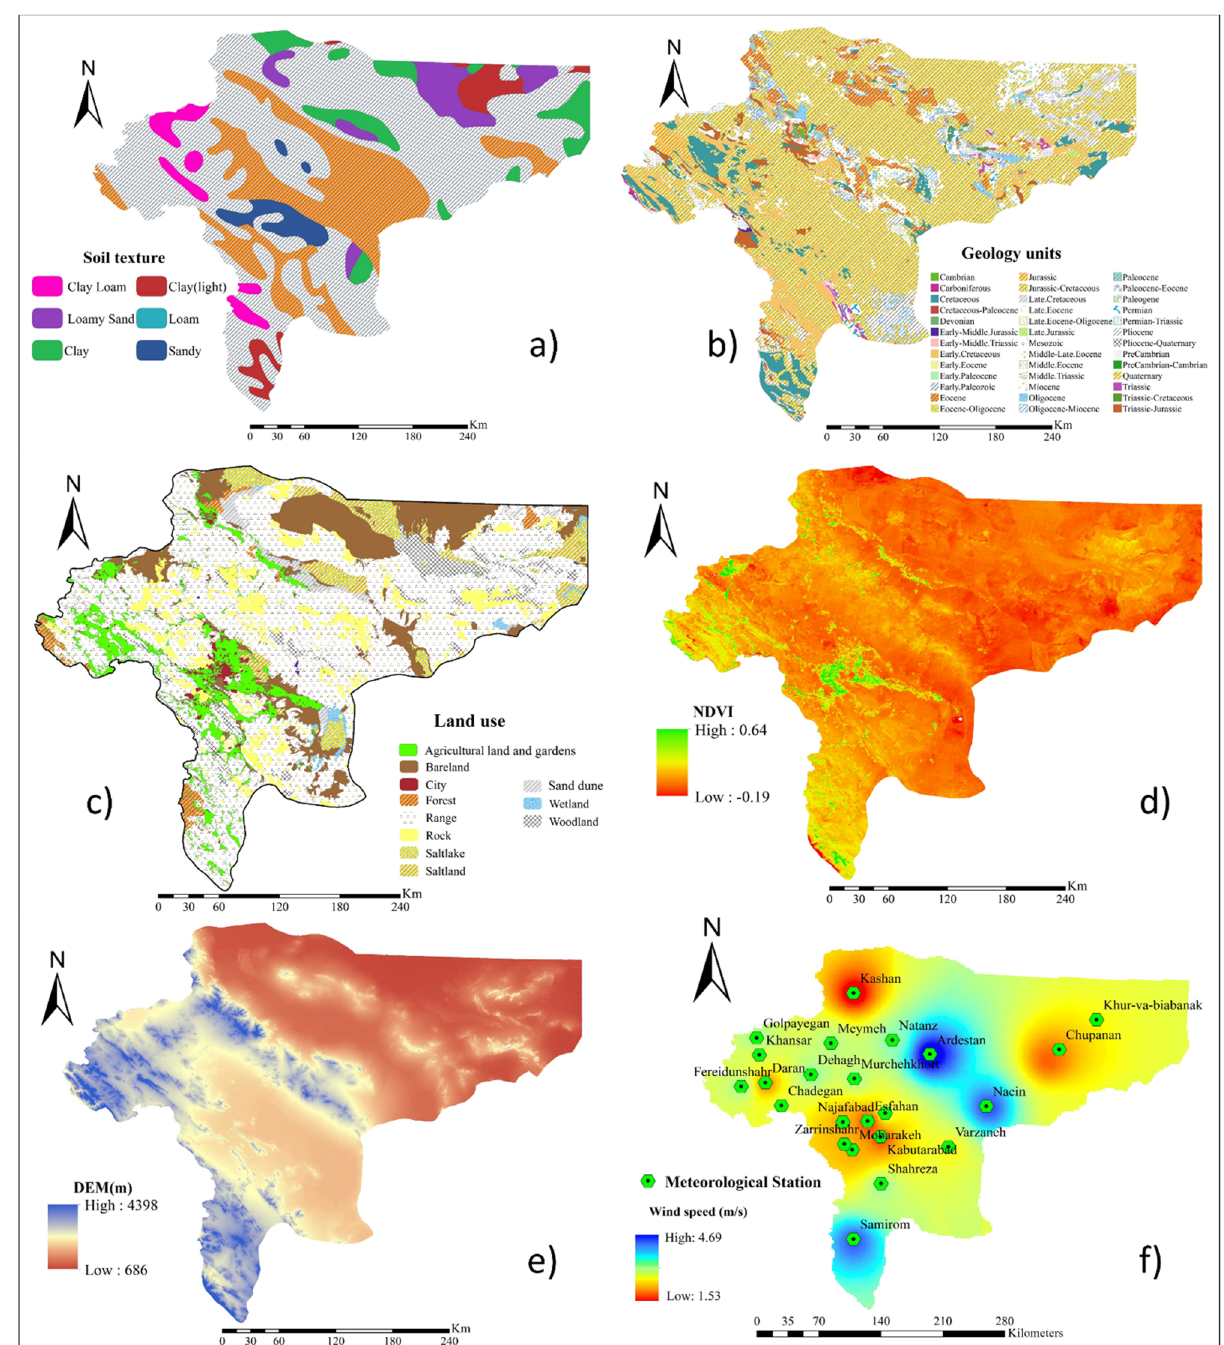
Figure 9. Spatial maps of: (a) soil texture; (b) geology; (c) land use; (d) NDVI; (e) DEM, and; (f) wind speed. All these factors were mapped spatially in ArcGIS 10.4.1 (https ://www.esri.com/en-us/about /about -esri/overv